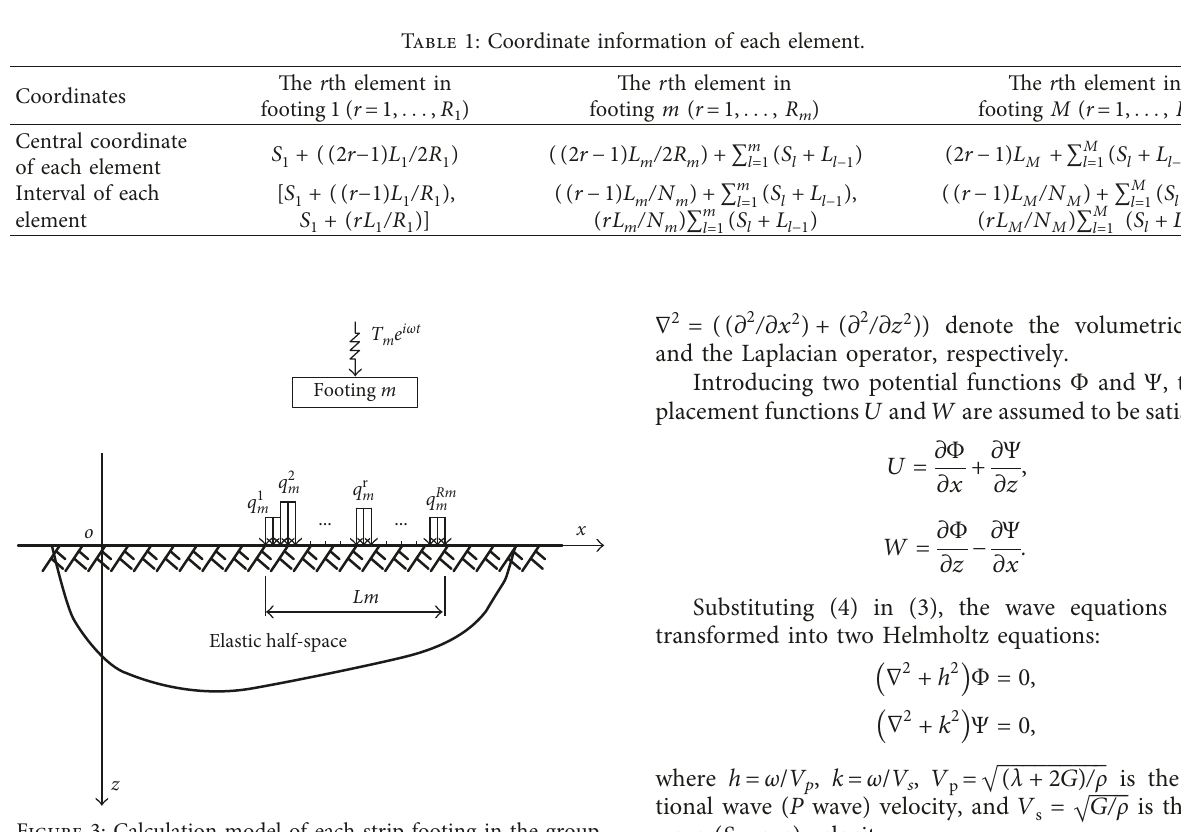
Figure 3: Calculation model of each strip footing in the vertical dynamic of the soil satisfies u The term exp( iωt ) is hereafter omitted from all displace- ments and forces for brevity. ε